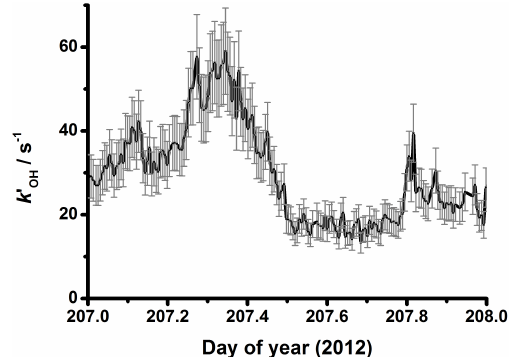
Figure 7. Time series of OH reactivity observed during the Clean Air for London (ClearfLo) campaign on the 25 July 2012 (Julian day 207). Error bars represent 1 σ combined uncertainties from the fits to observed OH decays (Eq. 5), determinations of k phys (Eq. 6) and uncertainties in the dilution factor, f (Eq. 7).